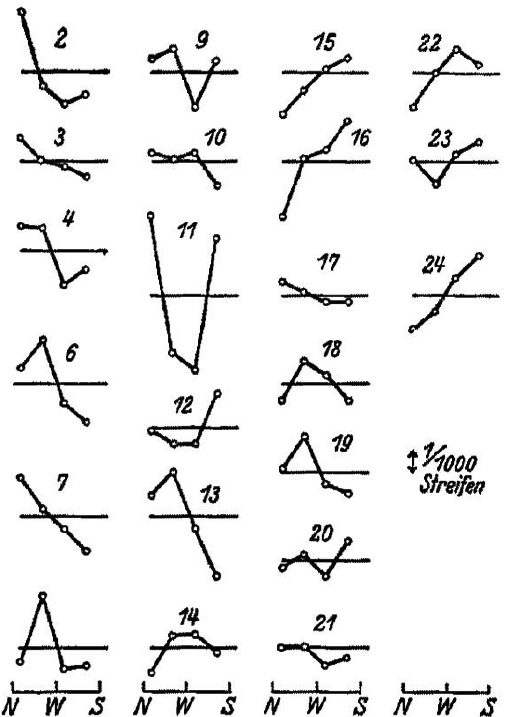
Figure 4. The fringe shifts reported by Joos [35]. The scale corresponds to 1/1000 of a